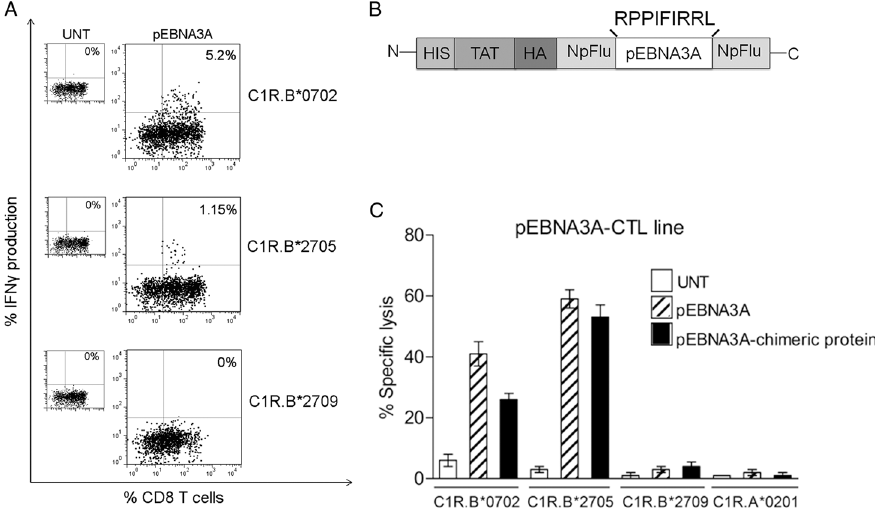
Figure 2. Uncanonical pEBNA3A presentation by HLA-B*2705 in a second B*2705/B*07- positive AS patient. (A) Measurement of IFN γ secretion in PBMCs from Don 2.05.07 stimulated with pEBNA3A for 14 d and then re-stimulated by untreated or pEBNA3A-pulsed C1R trans- fectants. Numbers represent the percentage of IFN γ -producing CD8 + T cells. (B) Schematic representation of the pEBNA3A-chimeric protein showing the location at the N-terminus of 6-His tag, the TAT transduction domain and the hemoagglutinin (HA) tag followed by the nucleoprotein of influenza A virus protein in which the sequence of EBNA3A epitope has been inserted. (C) 51 Cr-release assay in which cytolytic effector functions of a representa- tive pEBNA3A-stimulated CTL line was tested against C1R transfected cells, pre-pulsed with pEBNA3A provided as synthetic peptide (30 μ mol/L) or transduced by the chimeric protein carrying EBNA3A epitope (1 μ mol/L). E/T ratio was 20:1. Bars represent the mean percent- age of specific lysis ± SEM of three separate